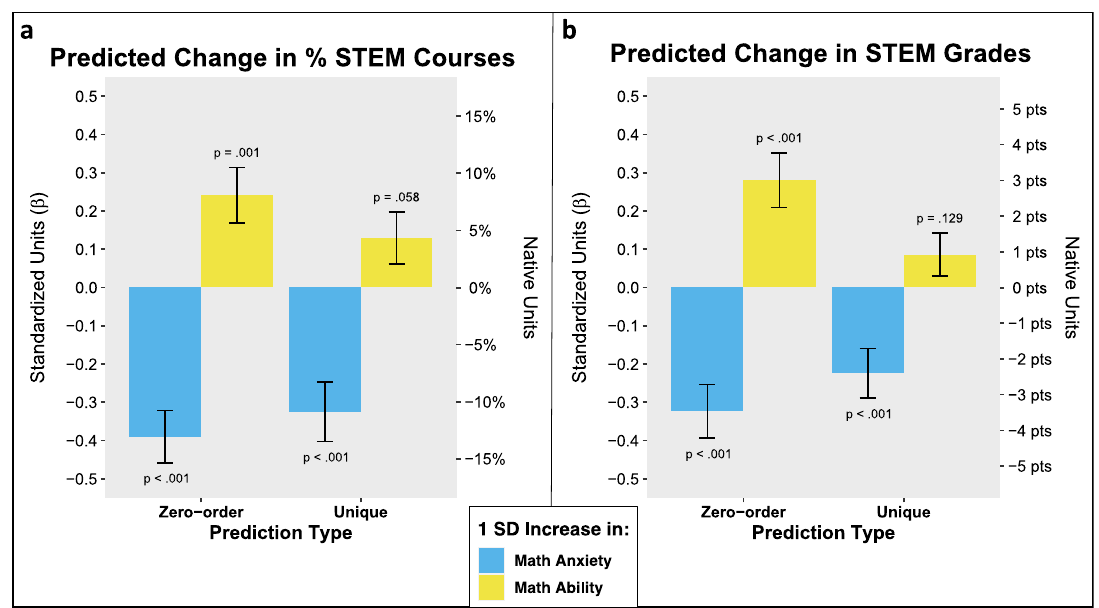
Fig. 1 Zero-order and unique predictive effects of fi rst-semester Math Anxiety and Math Ability on university STEM outcomes. Figure a shows the change in % STEM Courses associated with a 1 SD (standard deviation) increase in Math Anxiety and Math Ability. Zero-order relations between each predictor and % STEM Courses are plotted alongside unique relations between each predictor and % STEM Courses predicted by a multiple regression model including the following measures as predictors: Math Anxiety, Math Ability, STEM Grades, Trait Anxiety, Verbal Working Memory, Gender, non-STEM Grades, and Semesters Absent. Figure b is the same as Fig. a but displays the change in STEM Grades (in points out of 100) associated with a 1 SD increase in Math Anxiety and Math Ability as the dependent variable. The multiple regression model that generated the unique predictions included the same measures as predictors as that of Fig. a , but substituted % STEM Courses for STEM Grades. In both fi gures, the left y -axis shows the DV in standardized units, which corresponds to standardized β coef fi cients. The right y -axis shows the DV in the native units of each measure. Error bars re fl ect standard